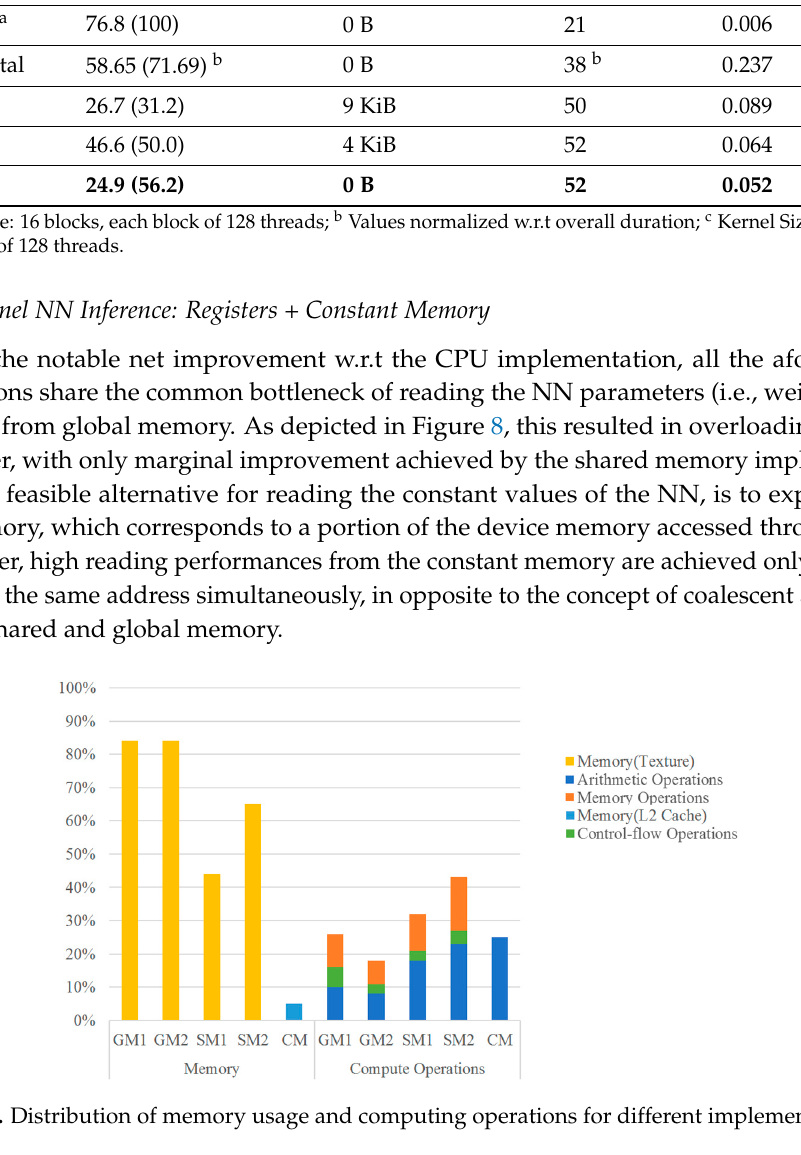
Table 4. Inference on GPU: GM2, SM1, SM2 and CM implementations for a batch of 512 NNs with a {16, 32|16|8, 4} topology.